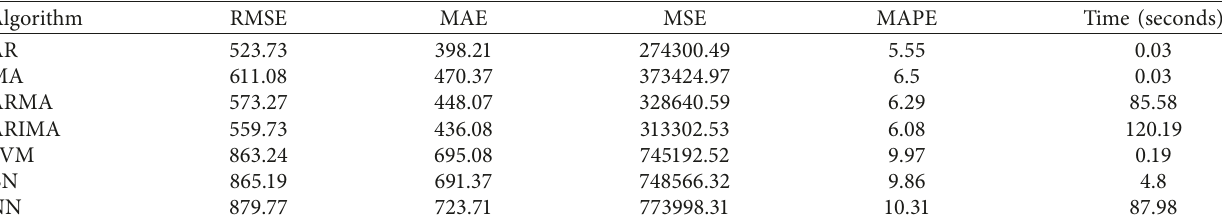
Figure 3: Structure of a multilayer neural network. Table 2: Analysis of algorithms for forecast